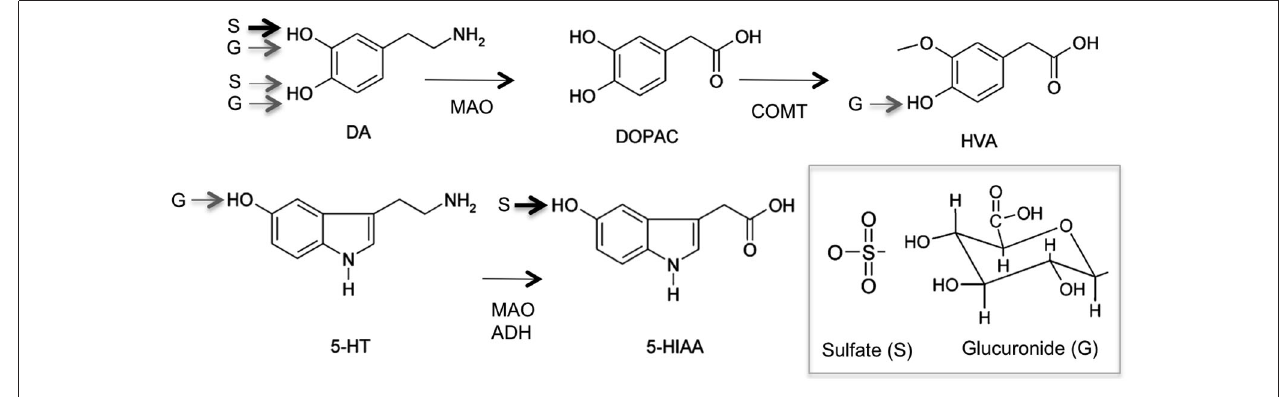
homovanillic acid (HVA), catechol-O-methyltransferases (COMT), 5-hydroxyindoleacetic acid (5-HIAA). Main sulfo- and glucuronoconjugate found in human brain are indicated by arrows (data from Suominen et al.,